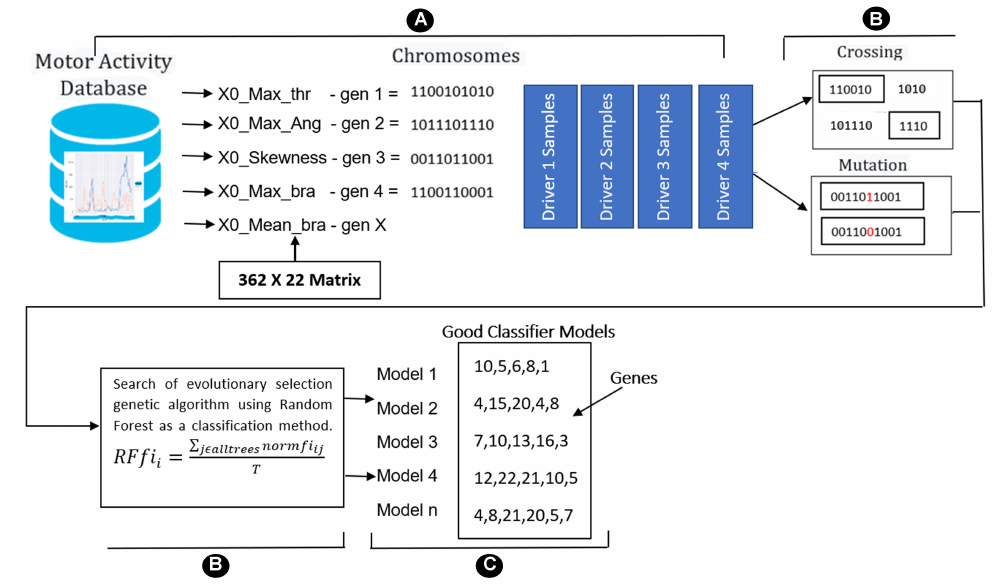
Figure 4. Schematic representation of multivariate variable selection using genetic